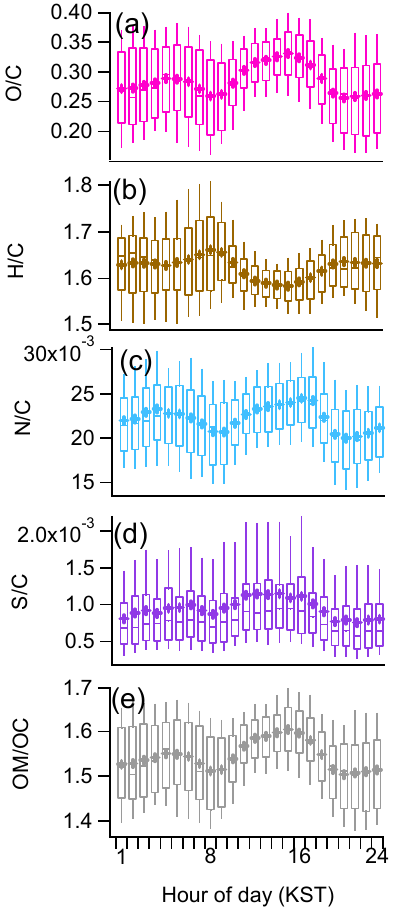
Figure 8. (a–e) Average diurnal profiles of the organic matter-to- organic carbon (OM / OC), oxygen-to-carbon (O / C), hydrogen- to-carbon (H / C), nitrogen-to-carbon (N / C), and sulfur-to-carbon (S / C) ratios of OA, where the O / C, H / C, and OM / OC elemen- tal ratios were determined using the updated method (Canagaratna et al.,